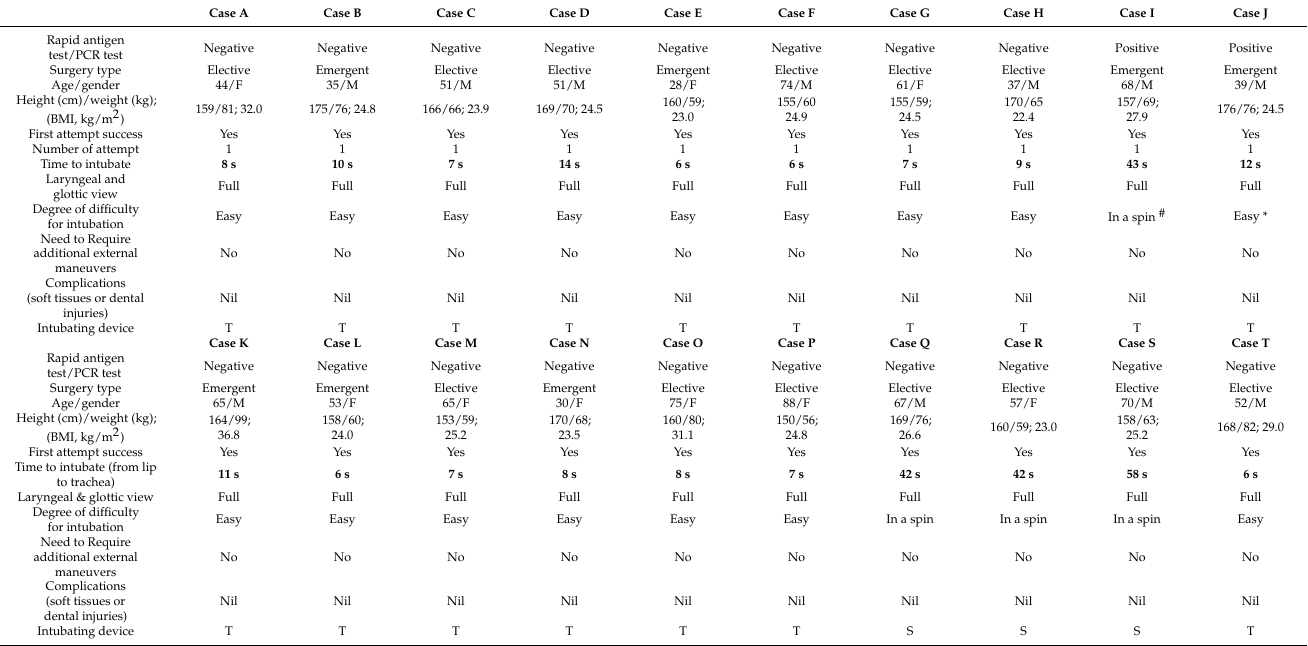
Table 1. Application of the Shikani technique and plastic sheet barrier for tracheal intubation during the Omicron pandemic (April 2022).